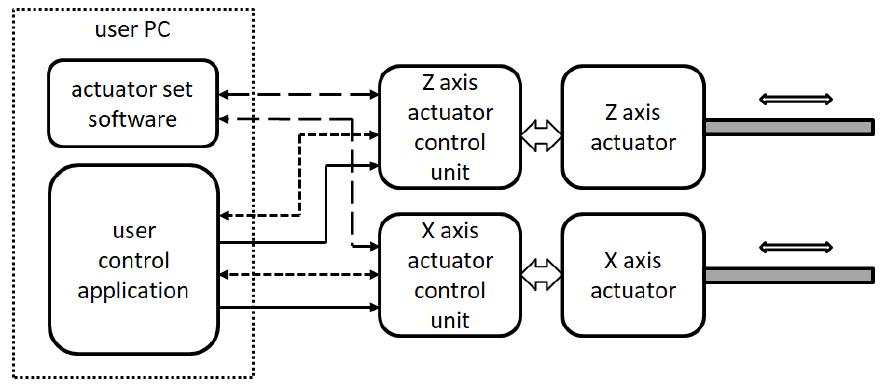
Figure 4. Block diagram of the testing device actuators connection.